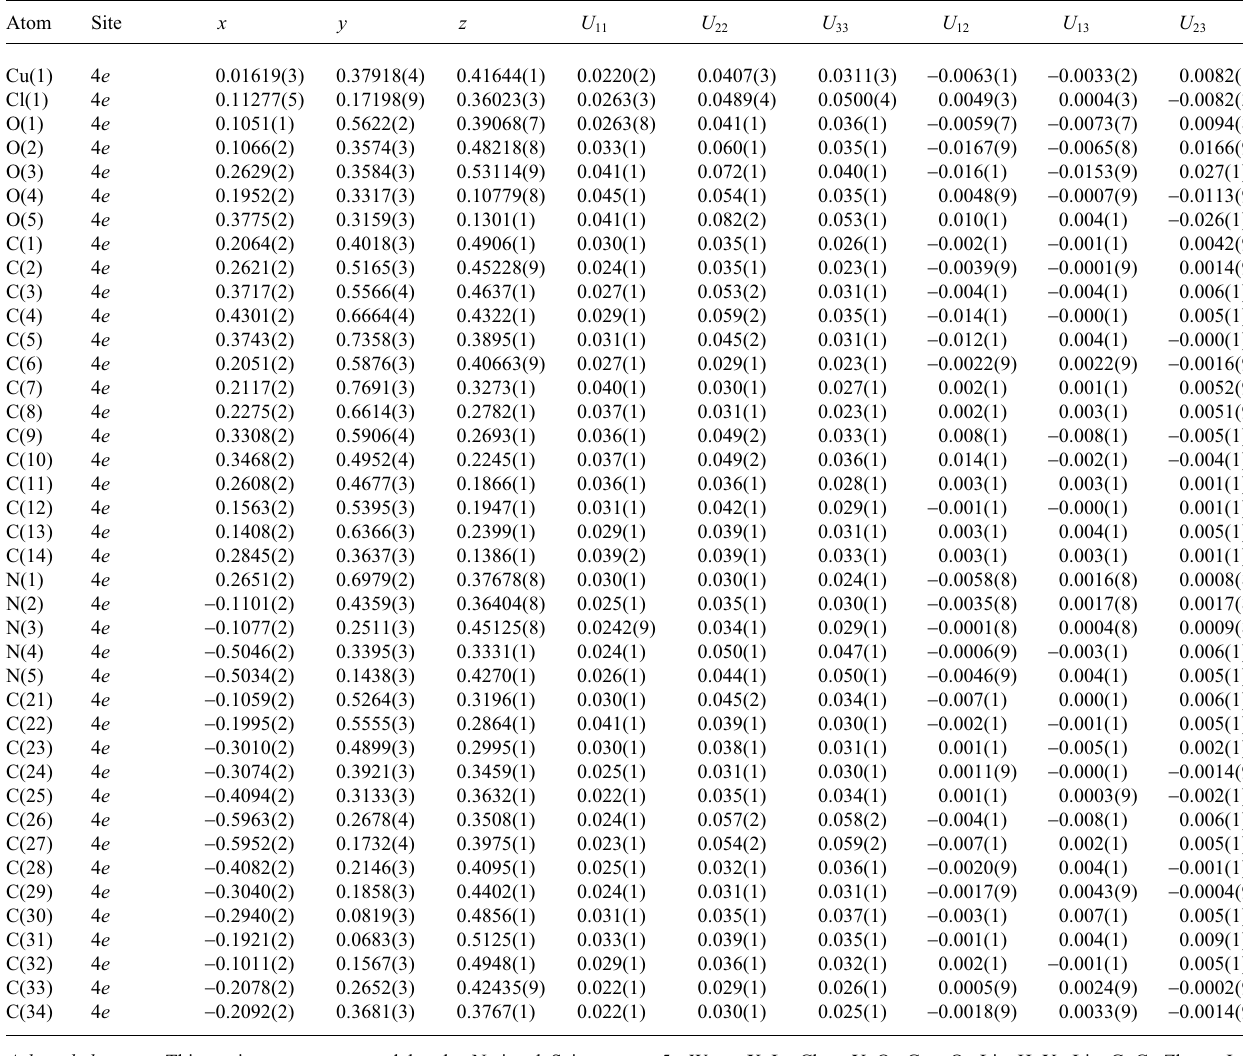
Table 3. Atomic coordinates and displacement parameters (in Å 2 )